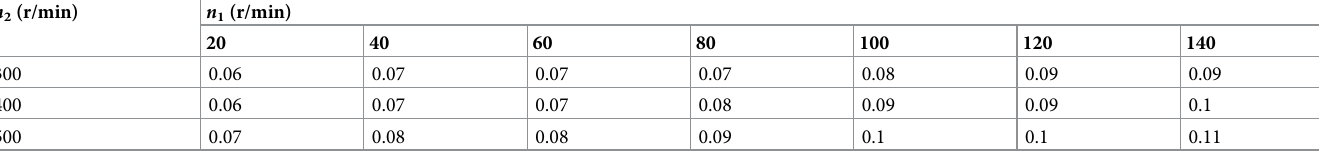
PLOS ONE | https://doi.org/10.1371/journal.pone.0266948 June 16,